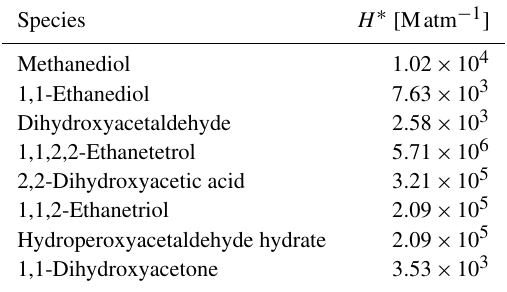
Table 2. Estimated effective ( H ∗ ) Henry’s law constants for all gem-diols represented in JAMOC. Estimates with the bond method (Meylan and Howard, 1991) are obtained from United States Envi- ronmental Protection Agency (US EPA) (2012). Species H ∗ [Matm − 1